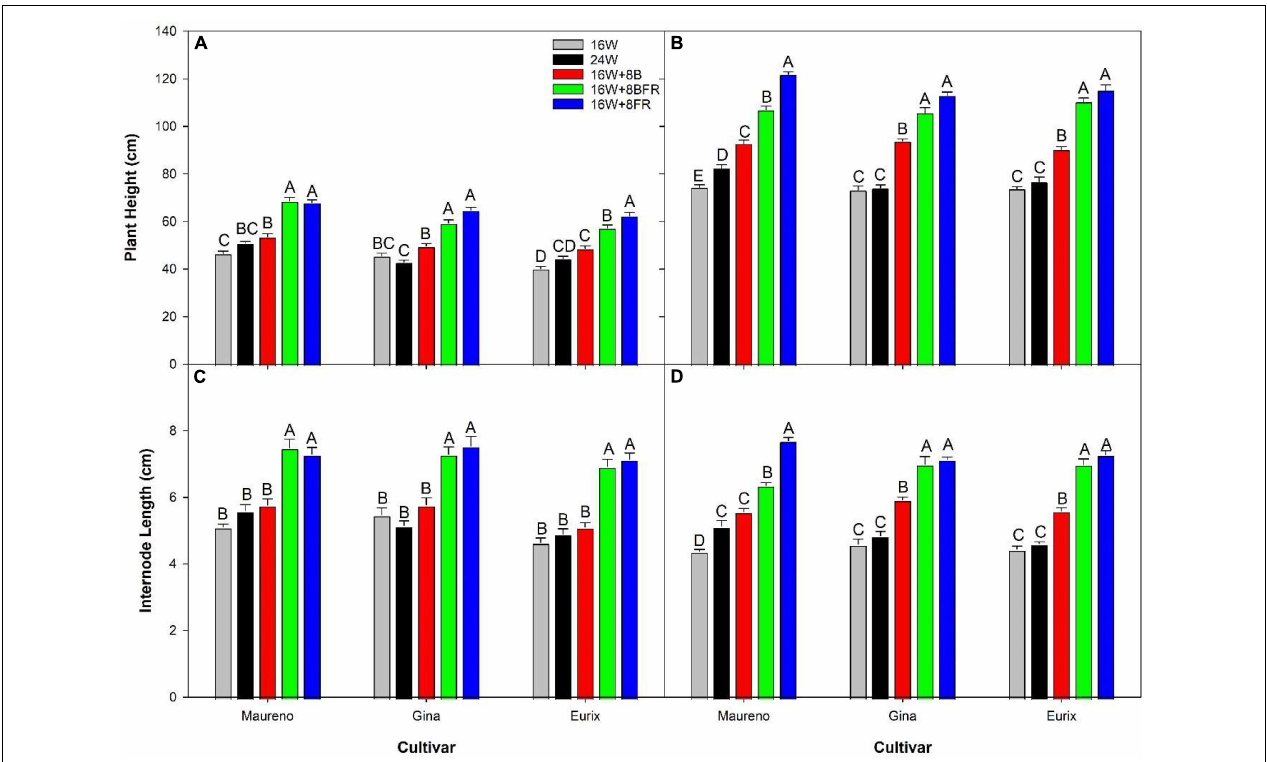
FIGURE 9 | Plant height (A,B) and internode length (C,D) for cv. ‘Maureno,’ ‘Gina,’ and ‘Eurix’ from experiment two measured at either 37–39 DIT (A,C) or 64–66 DIT (B,D) . Values and standard errors in (A,C) represent ten plants while those in (B,D) represent six plants. Within each panel and cultivar, letter groups (A, B, C, D, E) represent a statistical difference as determined by a one-way ANOVA with a Tukey-Kramer adjustment ( p <